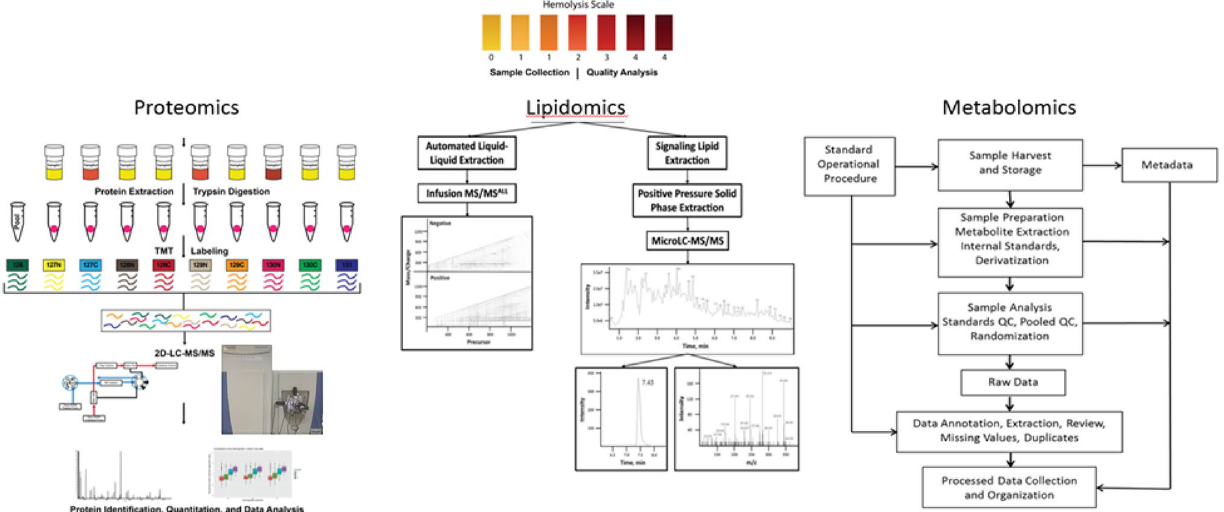
Figure 1. Workflow of the methods used to study the impact of Hemolysis. Initially, clinical samples were assigned a hemolysis score of 0–4 following the hemolysis scale color legend. In proteomics, plasma and serum were filtered and depleted of the top 14 most abundant proteins, and buffy coat cells were lysed. Proteins were extracted and digested with trypsin before being labeled with TMT 10-Plex. TMT-labeled peptides were analyzed using 2D LC–MS/MS platform and quantified using Proteome Discoverer v1.4. In lipidomics, structural lipids were extracted via liquid/liquid extraction method on an automated Hamilton Robotics STARlet system. Extracted lipids were analyzed via direct injection electrospray ionization TOF–MS. Further, mediator lipids were acidified and extracted using SPE. Eluted lipids were dried and resuspended